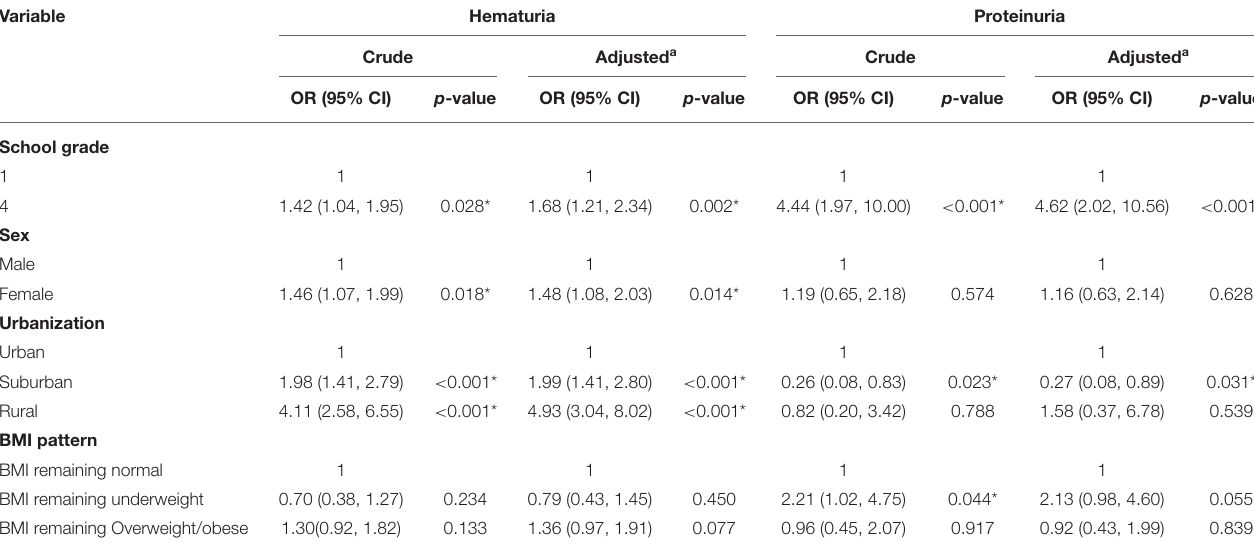
TABLE 2 | Factors associated with a higher risk of abnormal screening items ( n = 16,990). Variable Hematuria Proteinuria Crude Adjusted